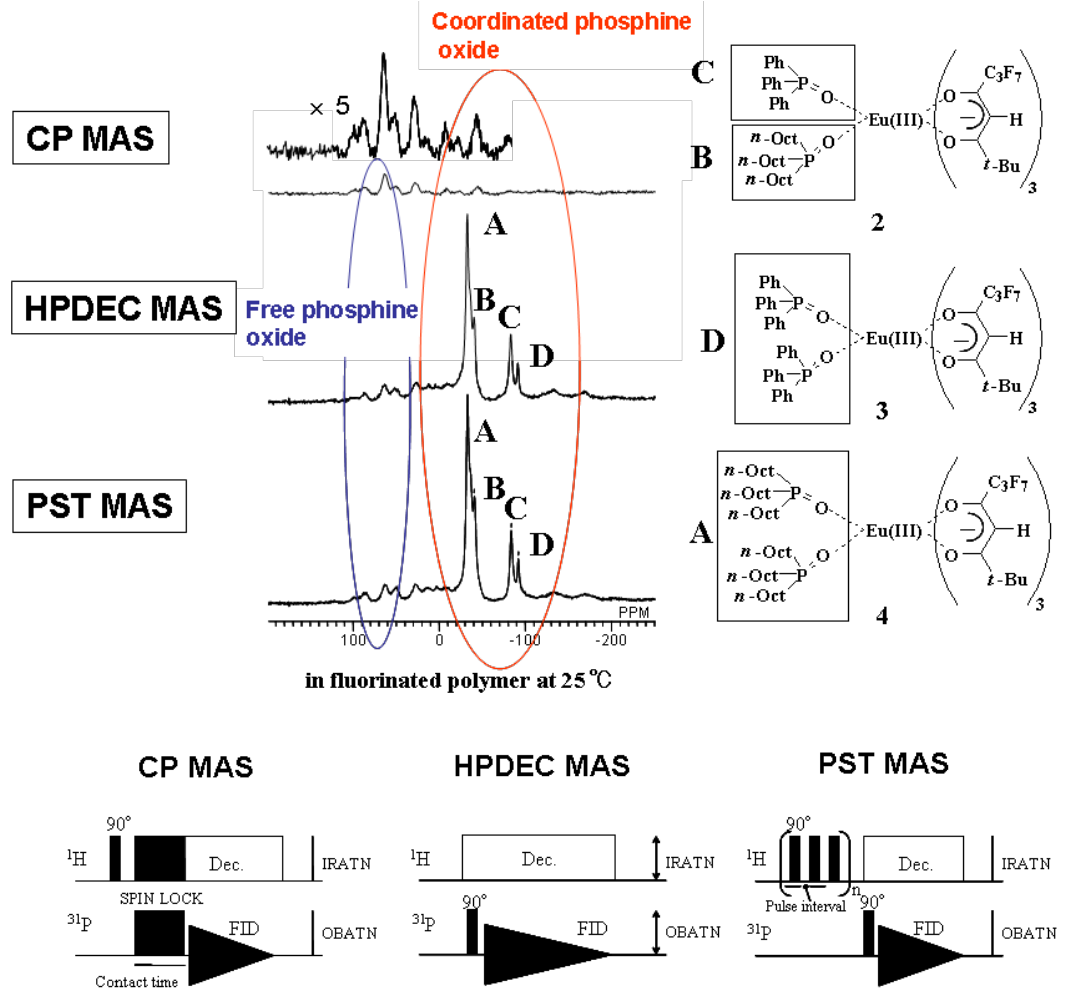
Figure 7. Comparison of three types of solid-state 31 P NMR spectra of the mixture of Eu(III) complex 1 , TOPO, and